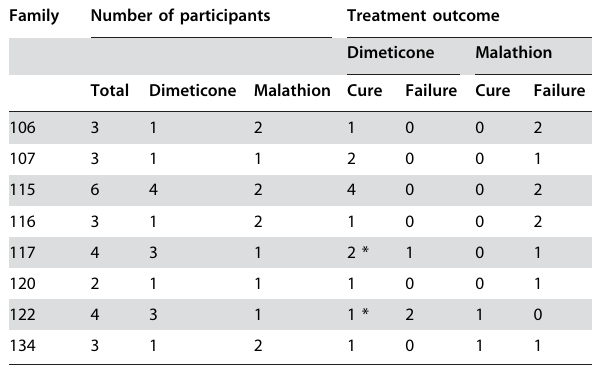
Table 3. Treatment outcome in households with